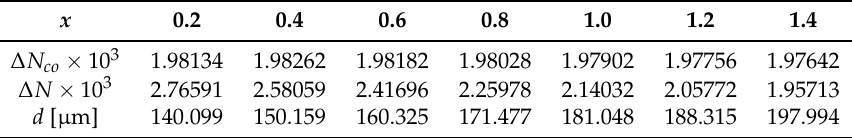
x Ga x O 12 on the difference −